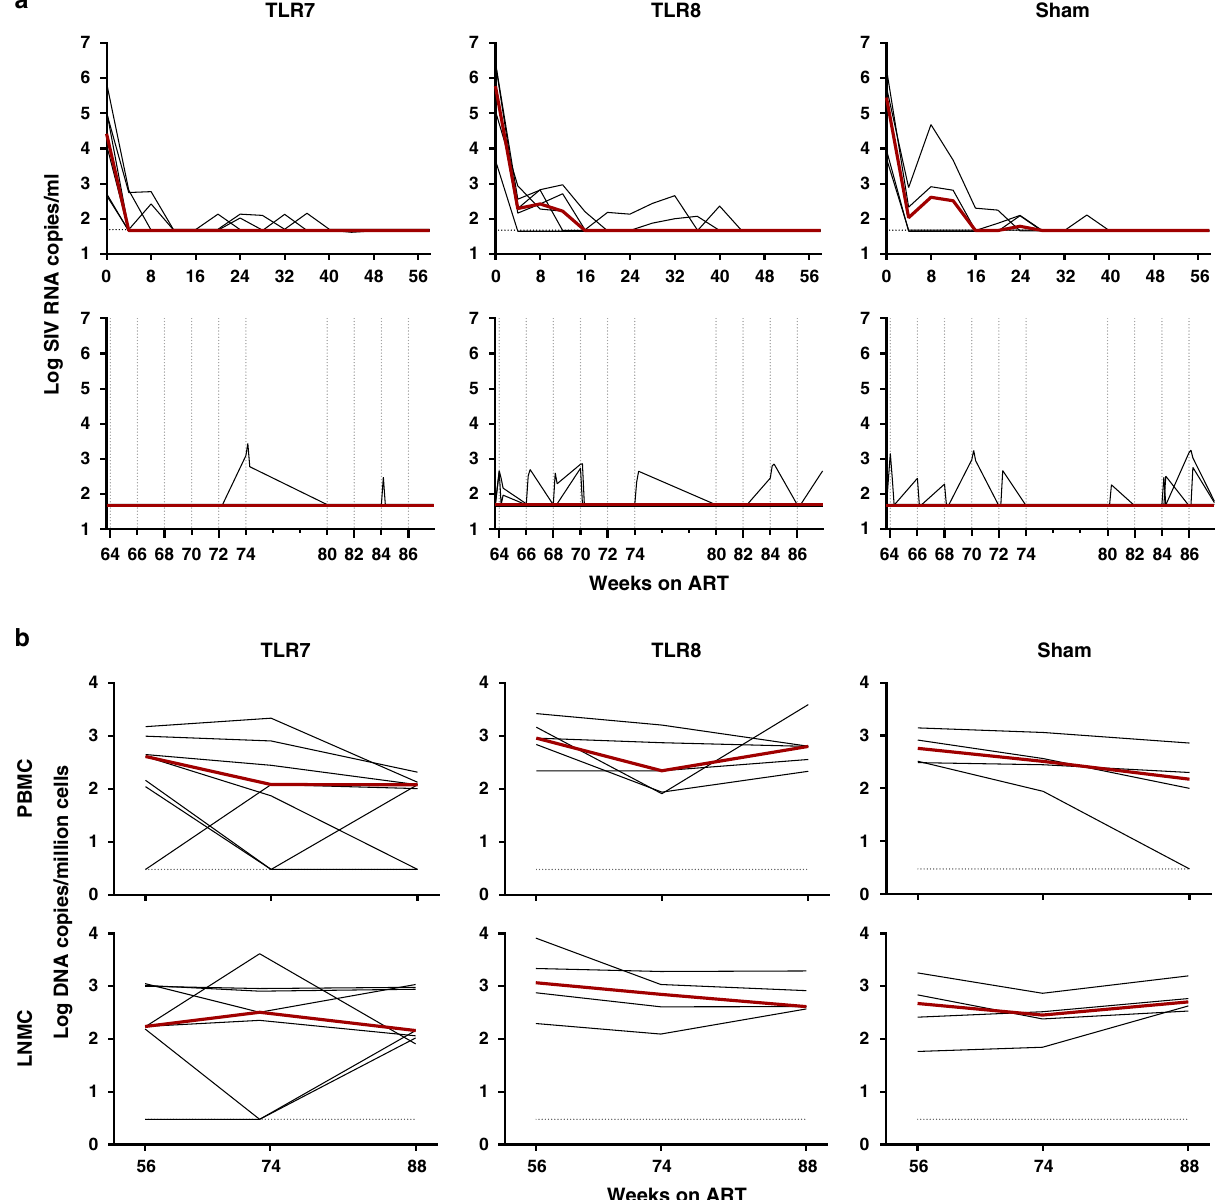
Fig. 1 Plasma SIV RNA and cell-associated DNA during ART suppression. a Plasma viral RNA (log copies/ml) is shown before (weeks 0 – 64) and during (weeks 64 – 86) TLR administrations. Vertical dashed lines re fl ect the 10 TLR administrations. The x -axis represents weeks following ART initiation. b Cell- associated viral DNA (log copies/million cells) in PBMC and LNMC. Red lines indicate median